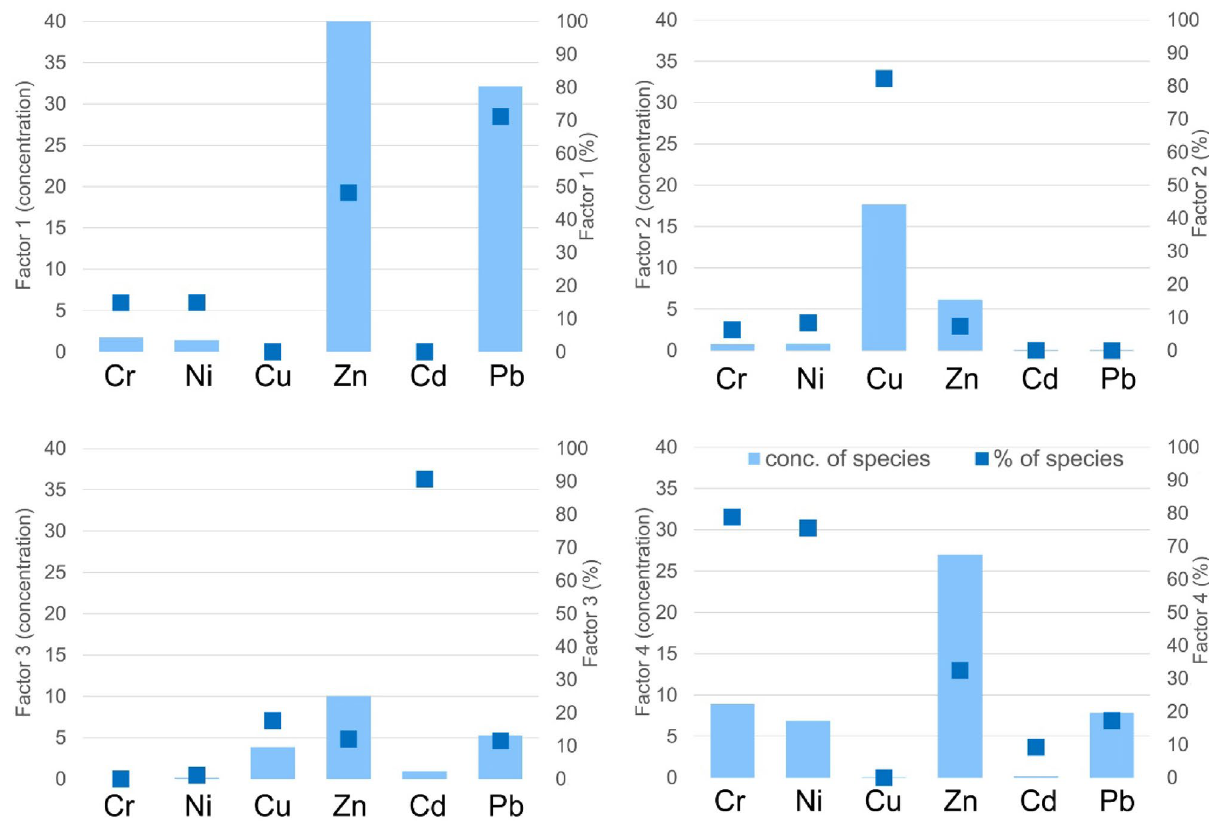
Figure 10. Identification of sources of HMs delivery by the PMF